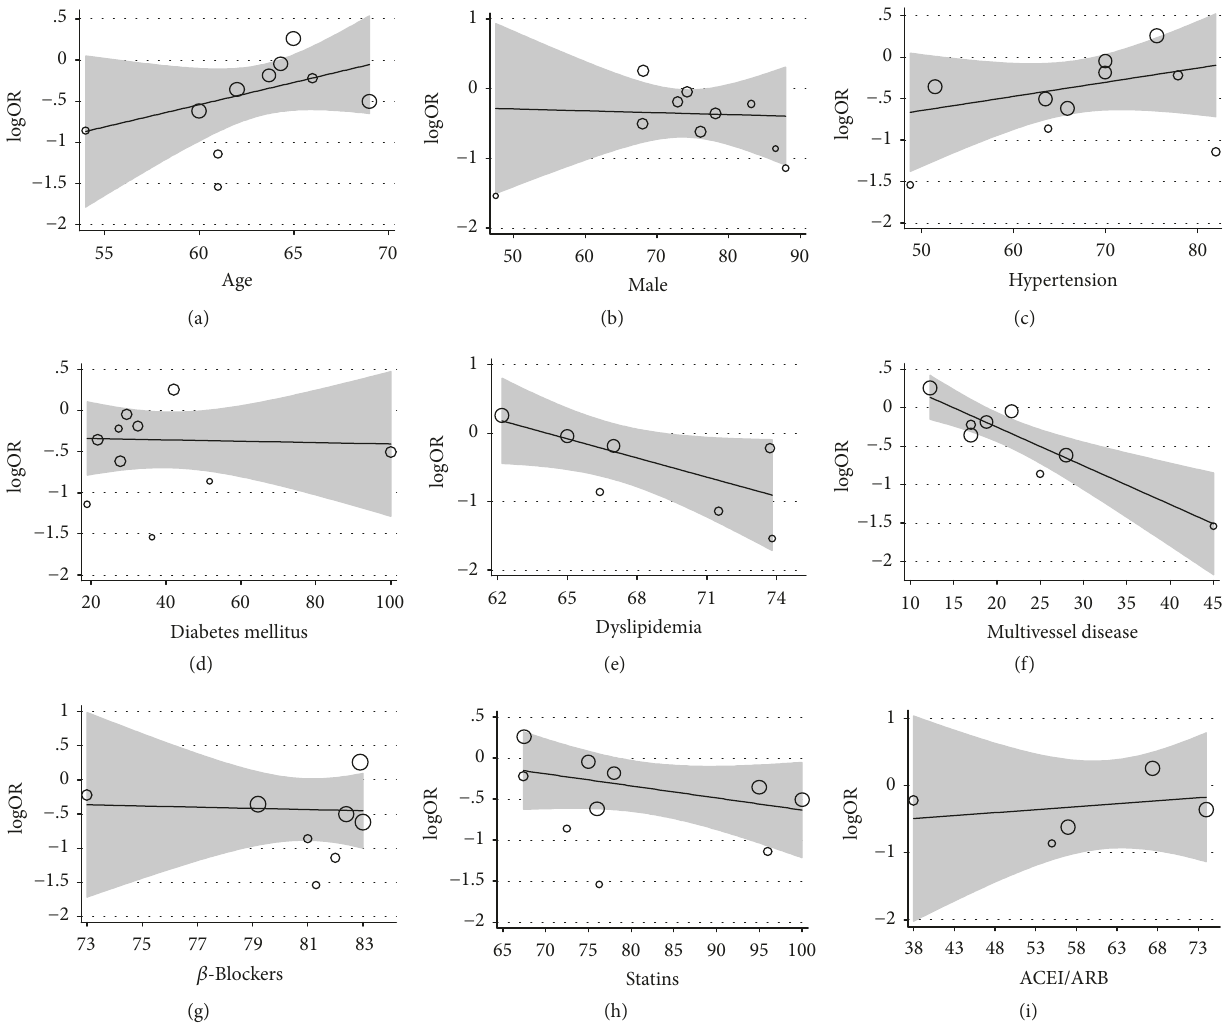
Figure 8: Metaregression results of reduction of PMI by RIPC. Metaregression of age (a), percentage of males (b), percentage of hypertension (c), percentage of diabetes mellitus (DM) (d), percentage of dyslipidemia (e), percentage of multivessel disease (f), percentage of 𝛽 -blockers used (g), percentage of statins used (h), and percentage of ACEI/ARB used